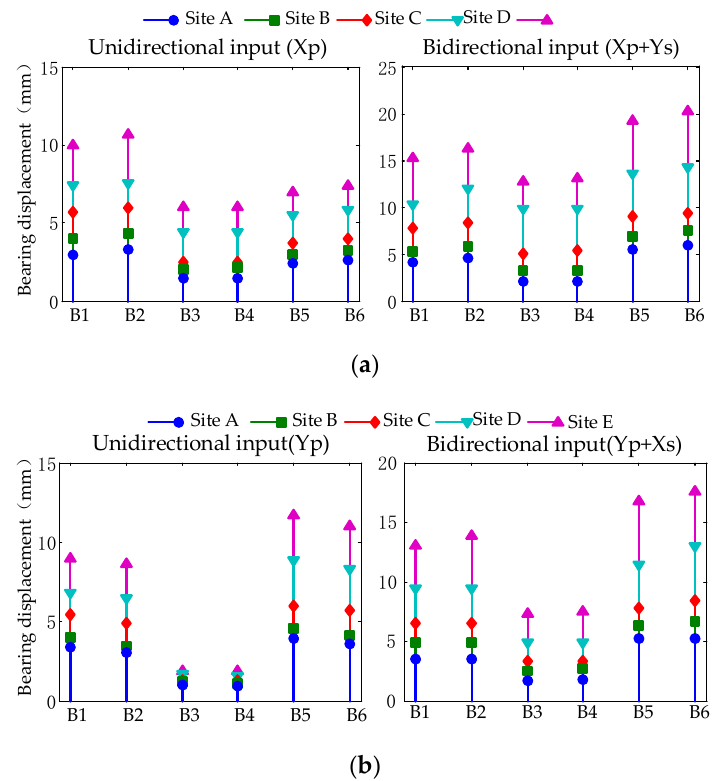
Figure 11. Relative displacement of bearing: ( a ) position A: curved bridge parallel to the direction of the principal ground motion; ( b ) position B: curved bridge perpendicular to the direction of the principal ground motion.